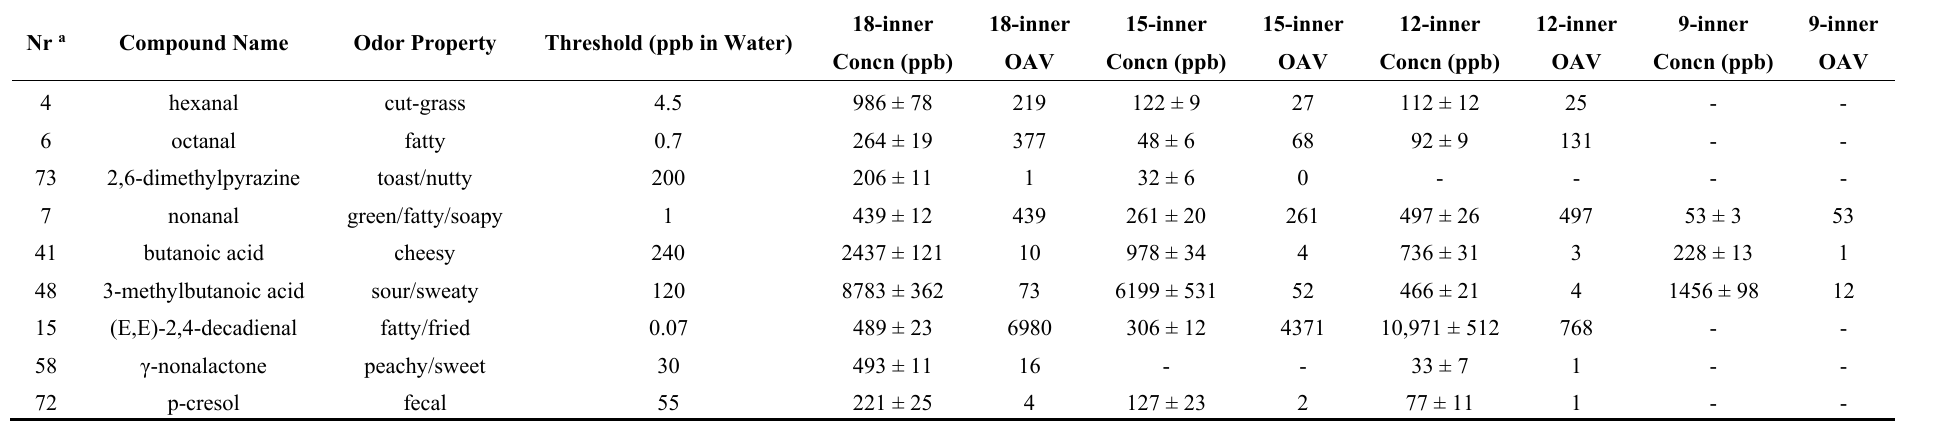
Table 4. OAVs of predominant odorants in Jinhua hams by